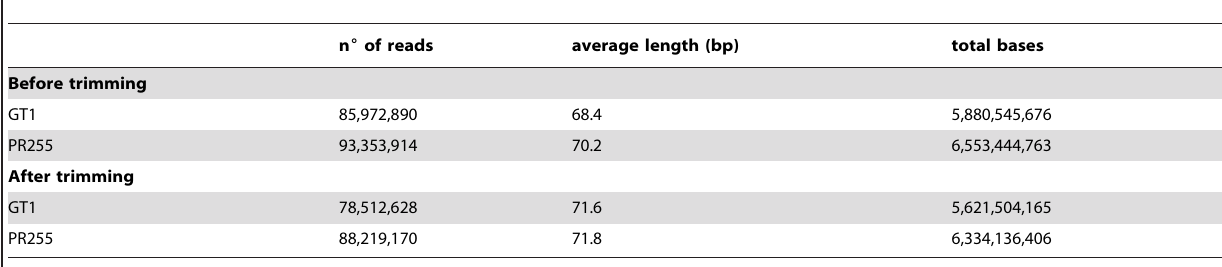
Table 1. Statistical summary of trimmed Illumina sequencing data.